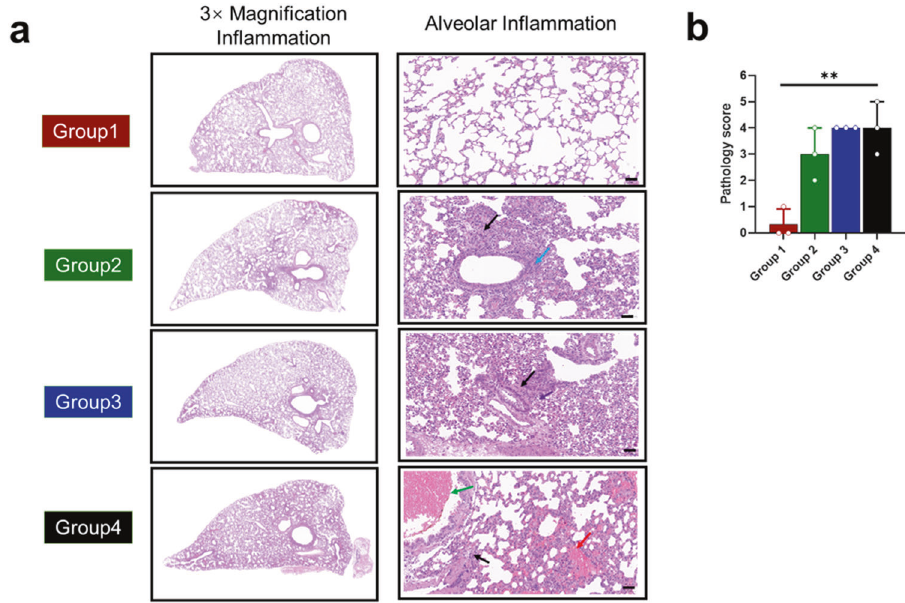
Fig. 3 Histopathological changes in the lung at 3 dpi in hamsters challenged with the Delta variant. a Representative images of the H&E- stained lung tissues of Group 1, 2, 3, and 4 hamsters at 3 days after Delta variant challenge. There was no obvious abnormality in the structure of the bronchus at any level. The alveolar wall was composed of a single layer of epithelium with a clear structure. No obvious in fl ammatory changes were observed (Group 1, prophylactic group). Lung tissue showed small foci of alveolar wall thickening with a small amount of neutrophil in fi ltration (black arrows); vascular congestion and dilation were common (green arrows) (Group 2, 3-dose antibody treatment group). Lung tissue showed mild alveolar wall thickening with neutrophil in fi ltration (black arrows); occasionally, there were a few necrotic epithelial cells, lymphocytes, and neutrophils in the bronchi (purple arrows) (Group 3, 2-dose antibody treatment group). Diffuse hemorrhage in the alveolar wall (red arrow) was seen in the lung tissue; a large number of blood cells in the bronchi were often seen (green arrow); multifocal thickening of the alveolar wall with neutrophil in fi ltration (black arrow) was seen (Group 4, control group without antibody). b Cumulative histopathological score of the lung lesions post Delta variant infection in hamsters. The mean along with standard deviation is plotted on the